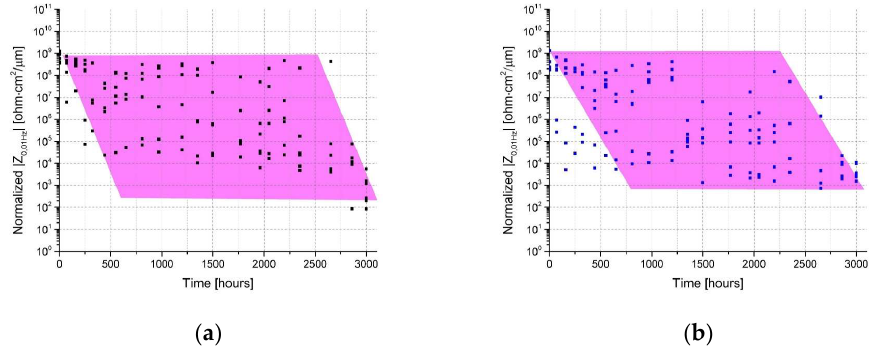
Figure 8. Impedance modulus at low frequencies (0.01 Hz) of painted steel ( a ) and HDG steel ( b ) samples vs. aging time in the prohesion test. ( b ) samples vs. aging time in the prohesion